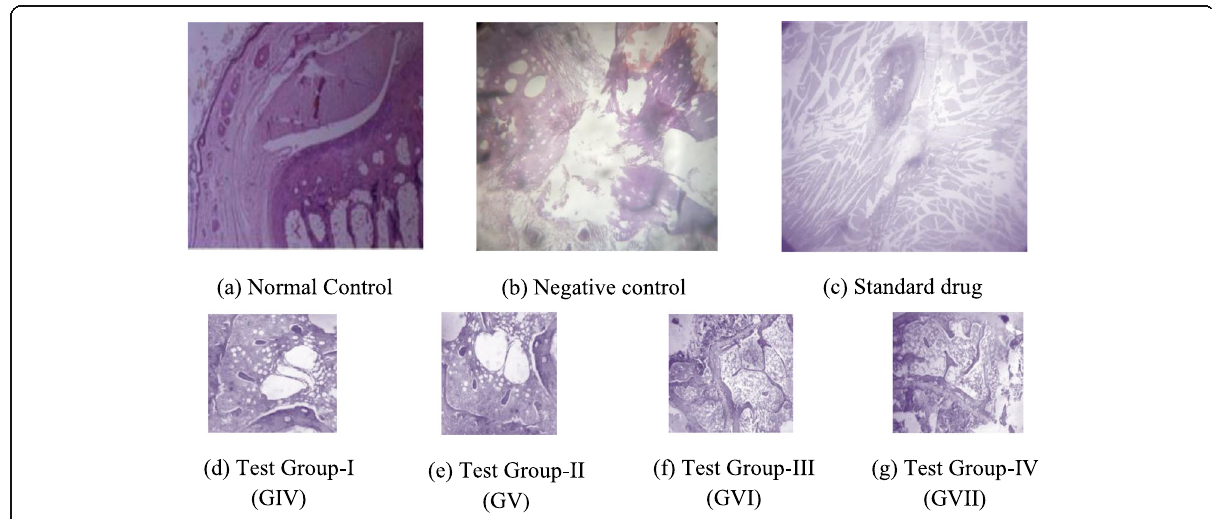
Fig. 12 Histopathology of joints. a = Control Group, b = Arthritic Control Group, c = Standard Group, d =PHC 100 mg treated 1st (GIV), e = PHC 100 mg treated 2nd Group (GV), f = PHE 100 mg treated (GVI) and g = PHE 100 mg treated